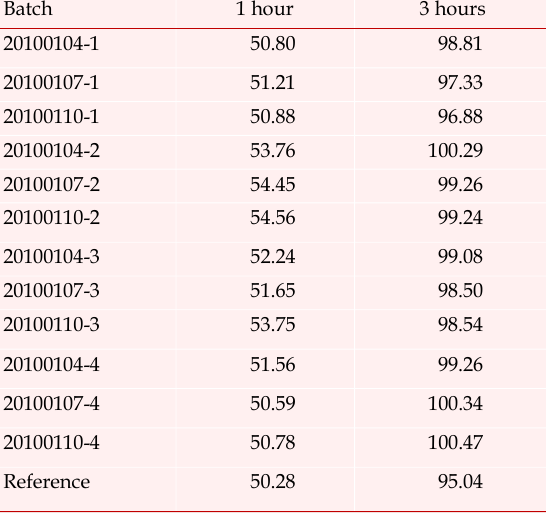
I n vitro release experimental results in 0.1M HCl